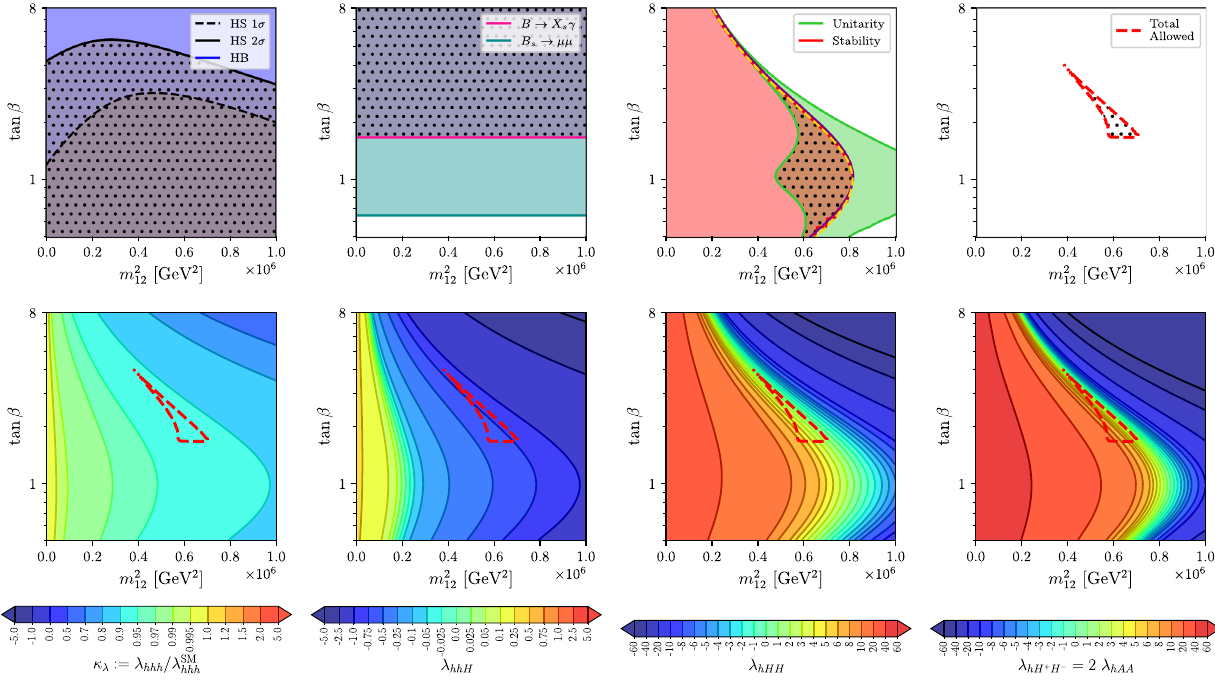
Fig. 12 Allowed areas (dotted regions) from the various constraints (upper row) and triple Higgs couplings (lower row) for the benchmark scenario IV-1 in the m 2